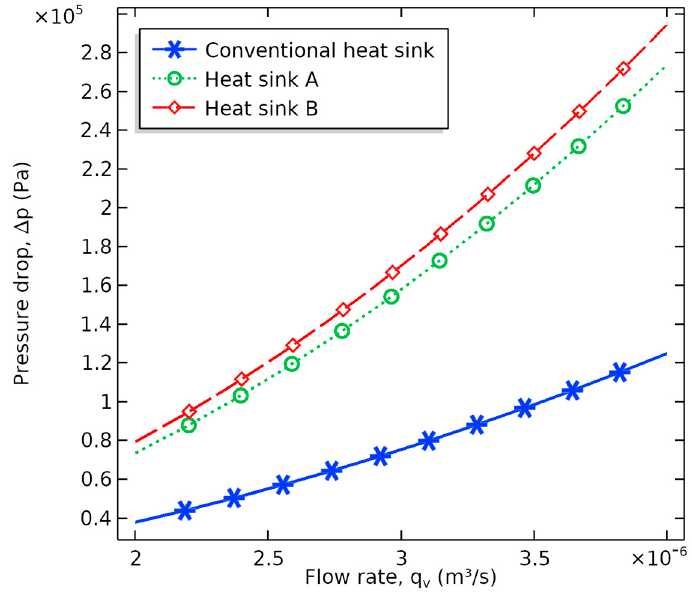
Figure 8. Pressure drop across the heat sinks versus volumetric flow rate.